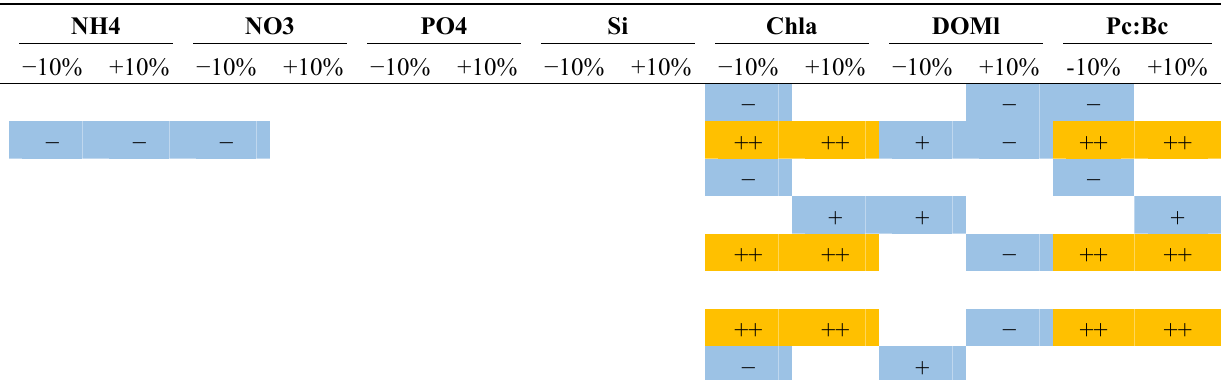
Table 10. SA result matrix for producers’ parameters impact on the analyzed variables. Color code: blue for sensitive ( S > 0.1), orange for highly sensitive ( S > 1) and red for extremely sensitive ( S > 10). The signs + and − stand for positive and negative perturbation, respectively. A description of the variables and parameters is found in Tables 1 and 2,